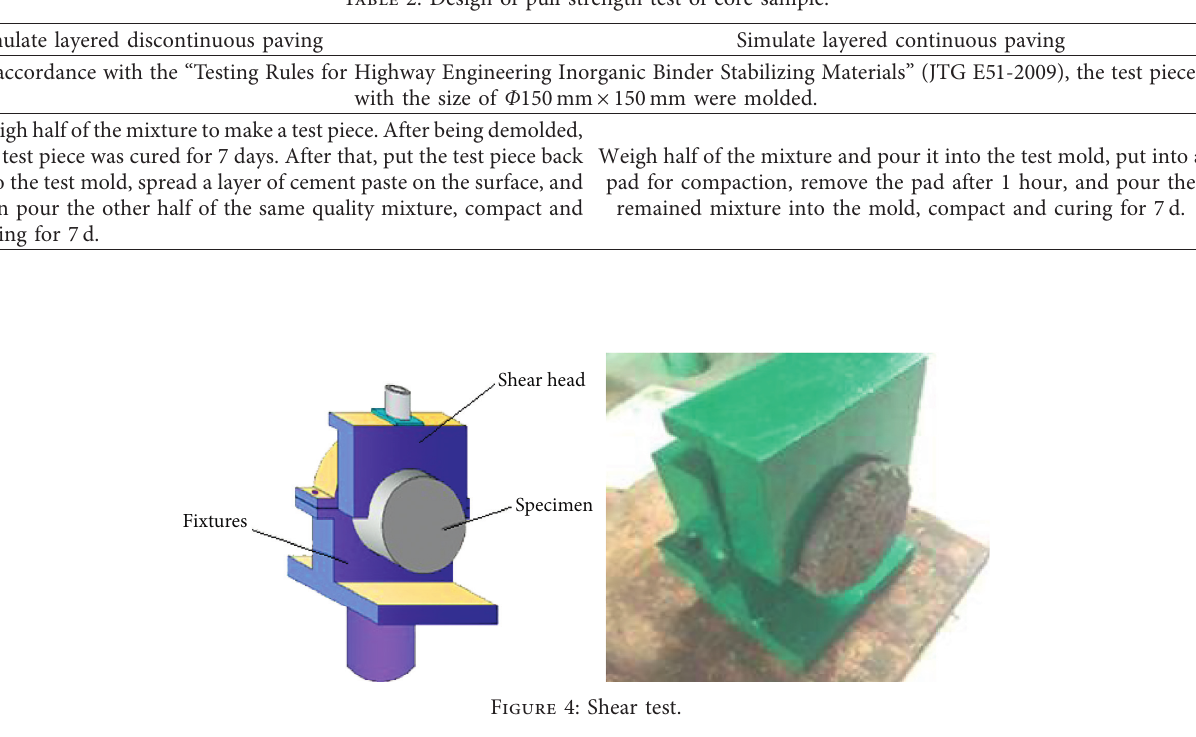
Table 2: Design of pull strength test of core